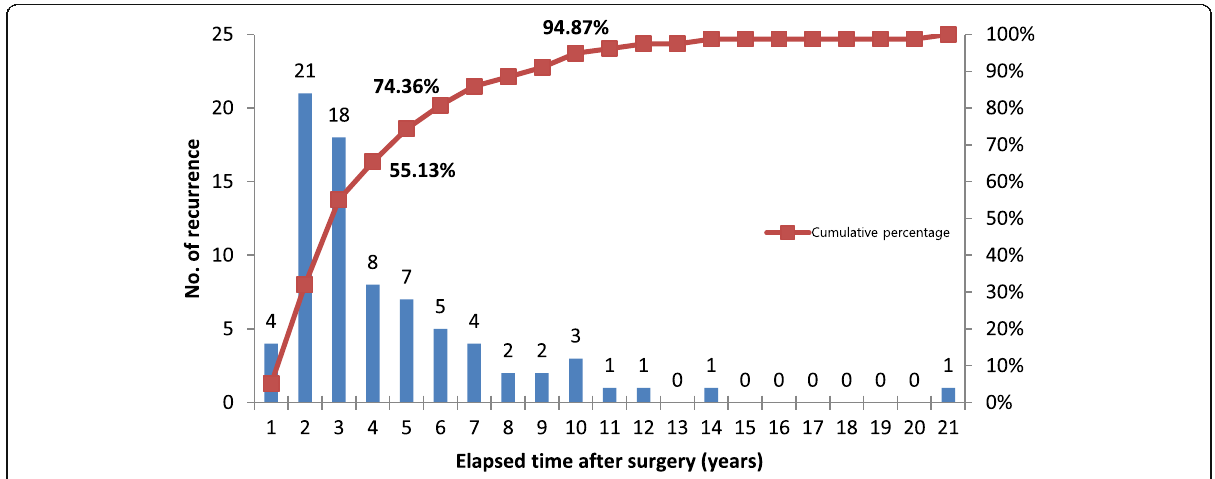
Fig. 3 Chronologic recurrence pattern of odontogenic